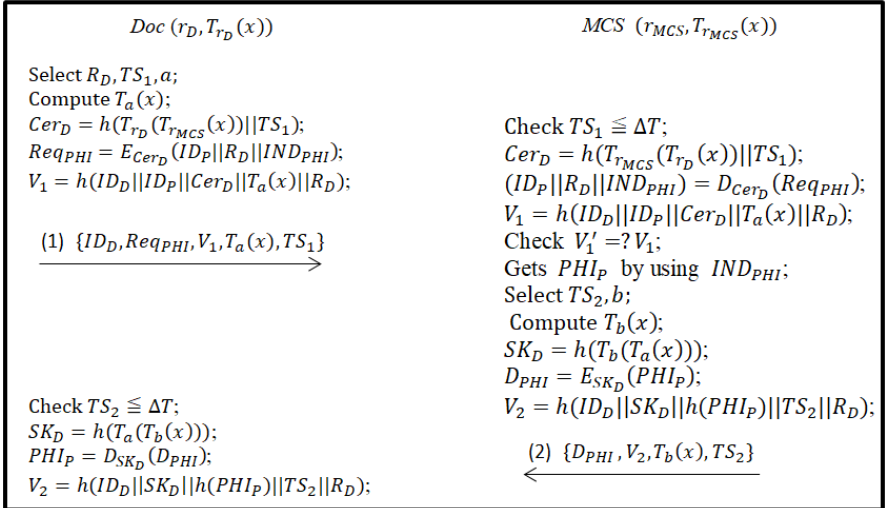
Figure 5. The processes of emergency-exception handling phase of the proposed scheme.